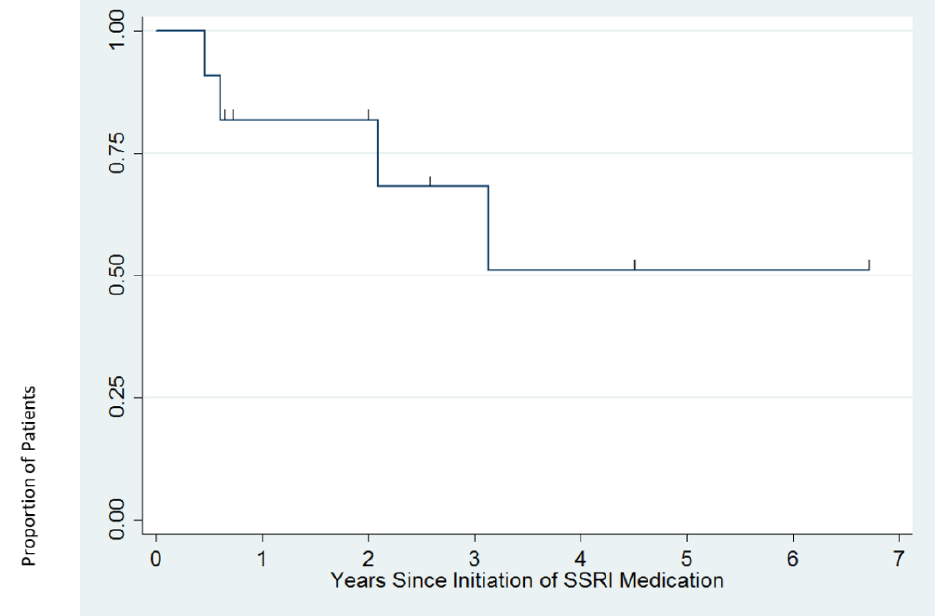
Figure 3. Proportion of patients remaining on SSRI medication over time. Tick-marks correspond to time of last psychiatric note for patients who remained on an SSRI at most recent psychiatric visit.